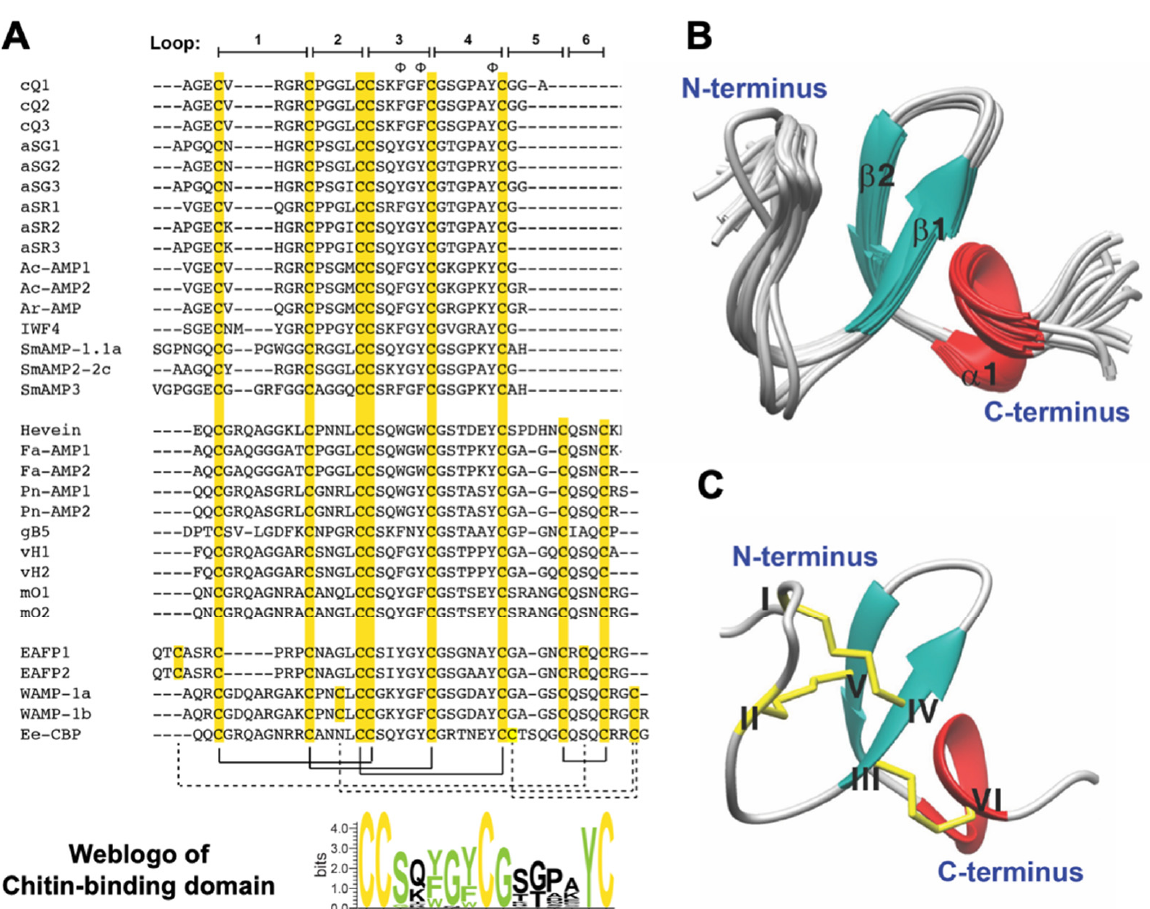
Figure 2. Sequence and solution structure of chenotide cQ2 (PDB:5ZV6). ( A ) Sequence alignment of chenotide cQ1, cQ2, and cQ3 with other reported chitin-binding hevein-like peptides, including altides aSG1–3, altides asR1–3, Ac-AMP1–2, Ar-AMP, IWF4, SmAMP-1.1a, SmAMP2-2c, SmAMP3, hevein, Fa-AMP1–2, Pn-AMP1–2, gingkotide gB5, vaccatide vH1–2, morintide mO1–2, EAFP1–2, WAMP-1a, WAMP-1b, and Ee-CBP. ( B ) Superposition of the chenotide cQ2 backbone traces from the final 20 ensembles solution structures and restrained energy minimized structure. ( C ) Ribbon representation of chenotide cQ2 structure. Φ represents aromatic residues essential for chitin-binding.